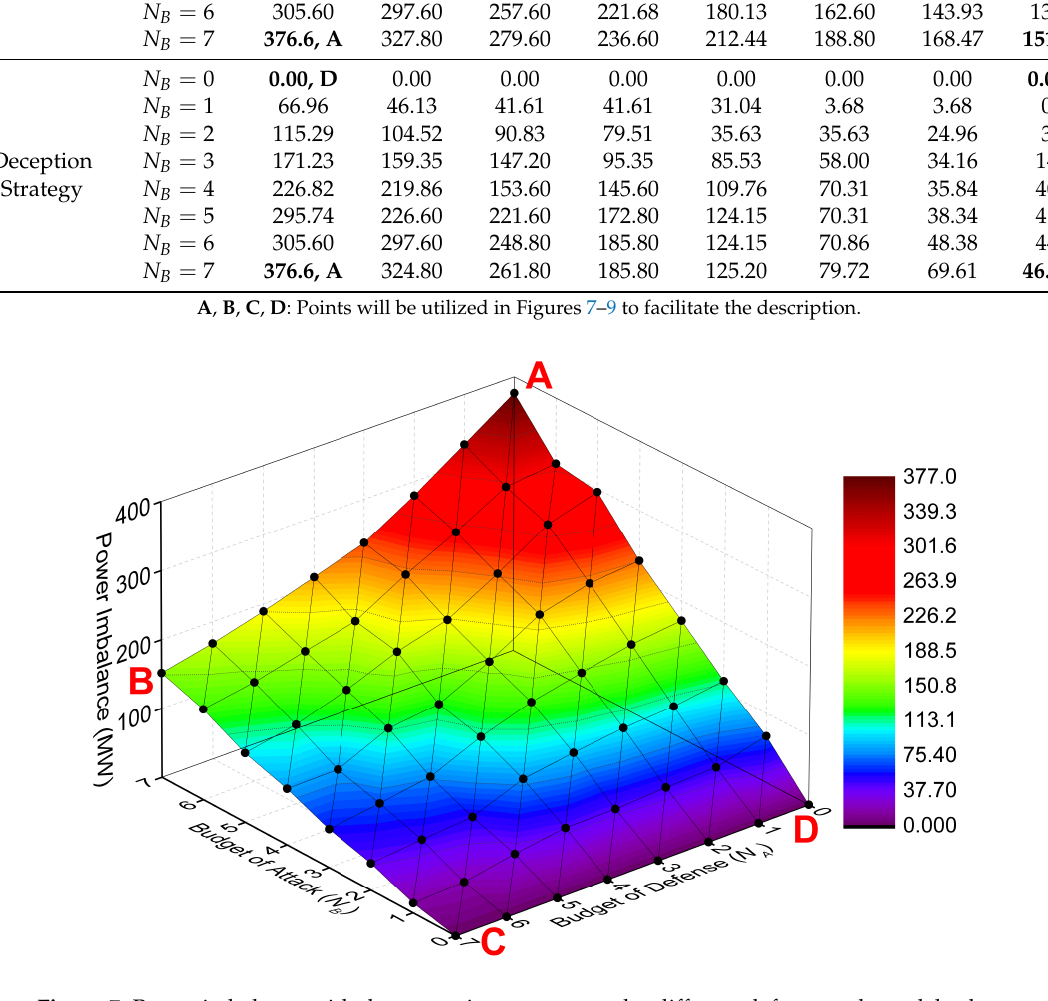
Figure 7. Power imbalance with the protection strategy under different defense and attack